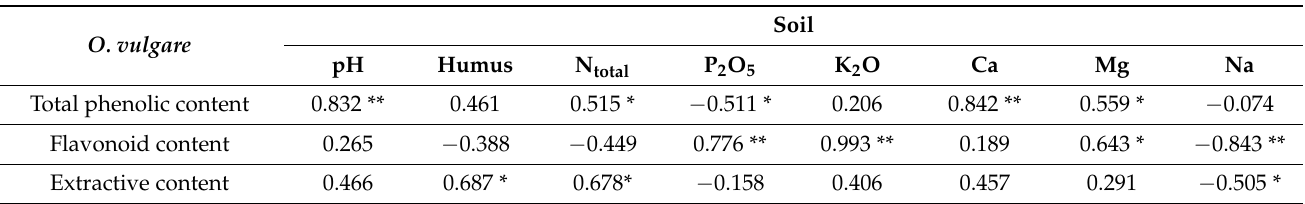
Table 3. Correlation between bioactive compounds of O. vulgare and soil chemical parameters (in all experimental fields,